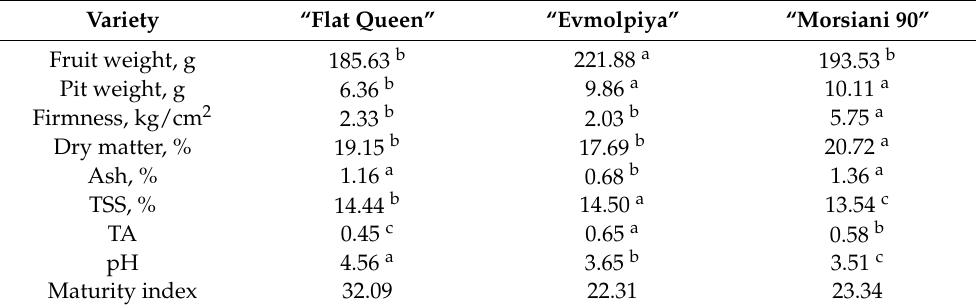
Table 2. Composition attributes and quality indices of late ripening peach ( Prunus persica L.) varieties. Variety “Flat Queen” “Evmolpiya” “Morsiani 90” Fruit weight, g 185.63 b Pit weight, g Firmness, kg/cm